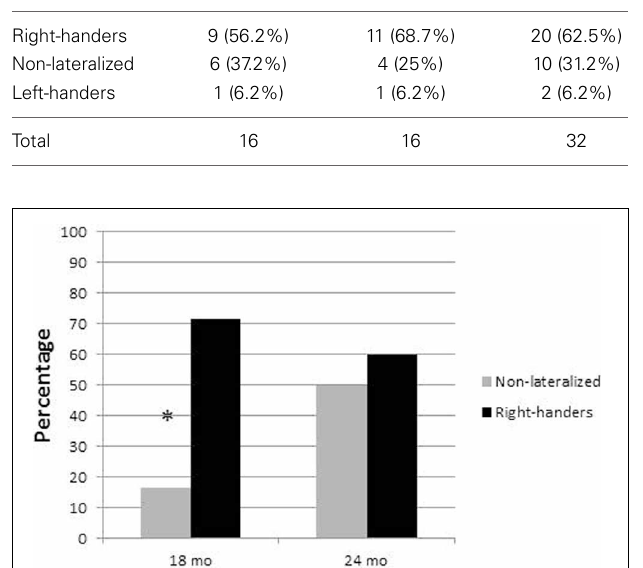
FIGURE 1 | Percentage of children with high vocabulary as a function of age and handedness. ∗ p < 0 .